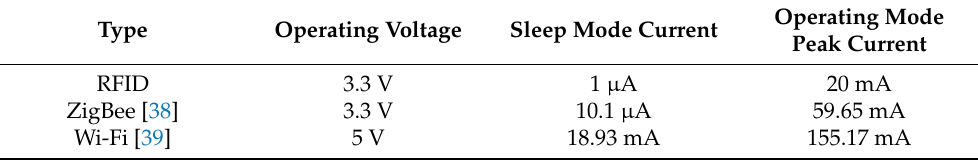
Table 4. Energy consumption of the RFID, ZigBee, and Wi-Fi communication transceivers.